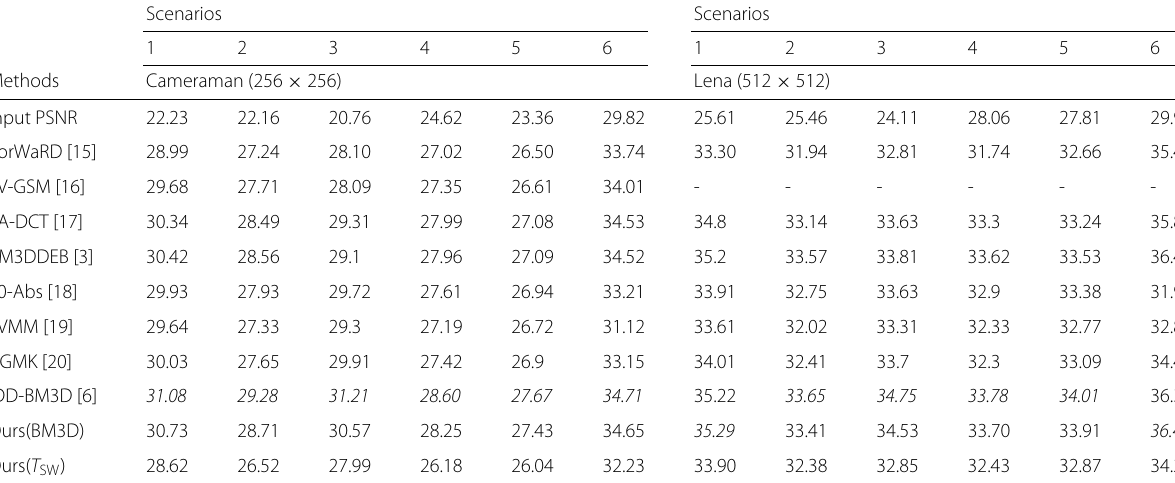
Table 2 PSNR of the methods in six scenarios Scenarios Scenarios